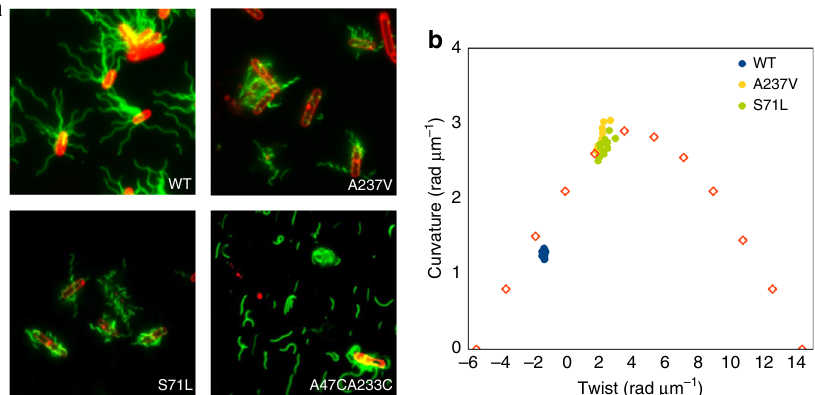
Fig. 6 Predicted mutations of B. subtilis fl agella fi laments. a Fluorescence images of wildtype, curly form mutations A237V and S71L, and relatively straight form disul fi de double mutant A47CA233C. b Plot of curvature κ against twist τ for measured helical forms of those B. subtilis mutants. The 12 discrete points corresponding to different theoretical waveforms in S. enterica are shown by empty red squares